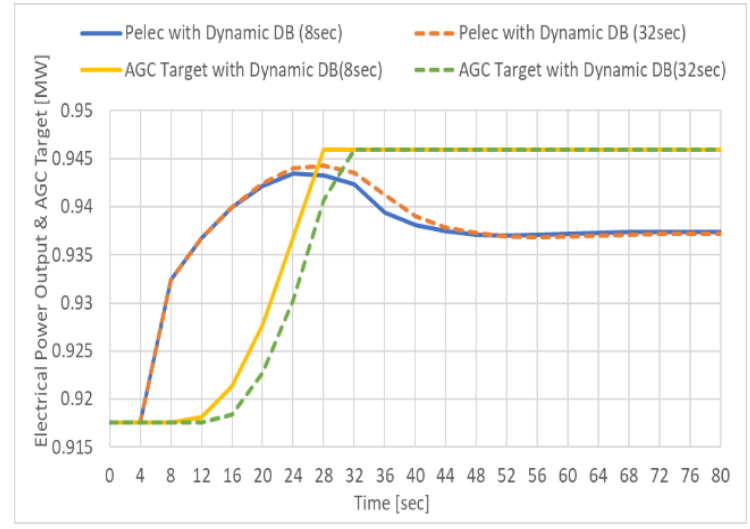
Figure 18. The area control error activation time ( upper ) and the frequency response of generator ( lower ) depending on variable times of the dynamic deadband.